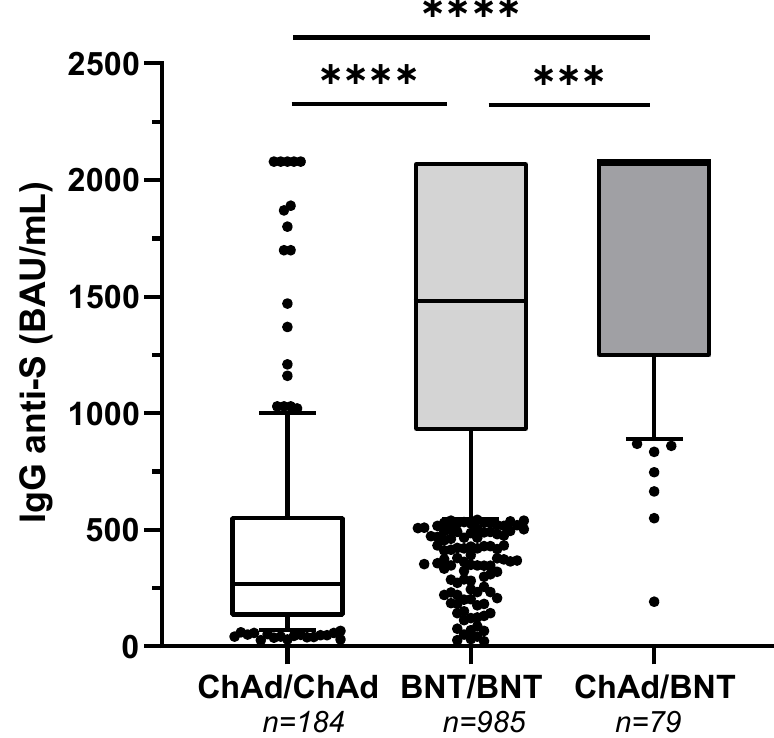
Figure 1. Heterologous ChAdOx1-S nCoV-19/BNT162b2 prime-boost vaccination enhances antibody titers. Comparison of anti-trimeric spike protein IgG antibodies to SARS-CoV-2 among three different groups of vaccinated subjects. ChAd/ChAd denotes an Oxford-AstraZeneca ChAdOx1-S nCoV-19 vaccine for prime and second doses. BNT/BNT denotes a Pfizer-BioNTech BNT162b2 vaccine for prime and second doses. ChAd/BNT denotes a ChAdOx1-S nCoV-19 vaccine for the prime dose and a BNT162b2 vaccine for the second dose. The serum samples were analyzed approximately two months after the second dose. Box-whisker plot displaying the 90/10 percentile at the whiskers, the 75/25 percentiles at the boxes, and the median in the center line. **** p < 0.0001, *** p < 0.001, Kruskal Wallis test with Dunn ´ s multiple comparisons post-test.